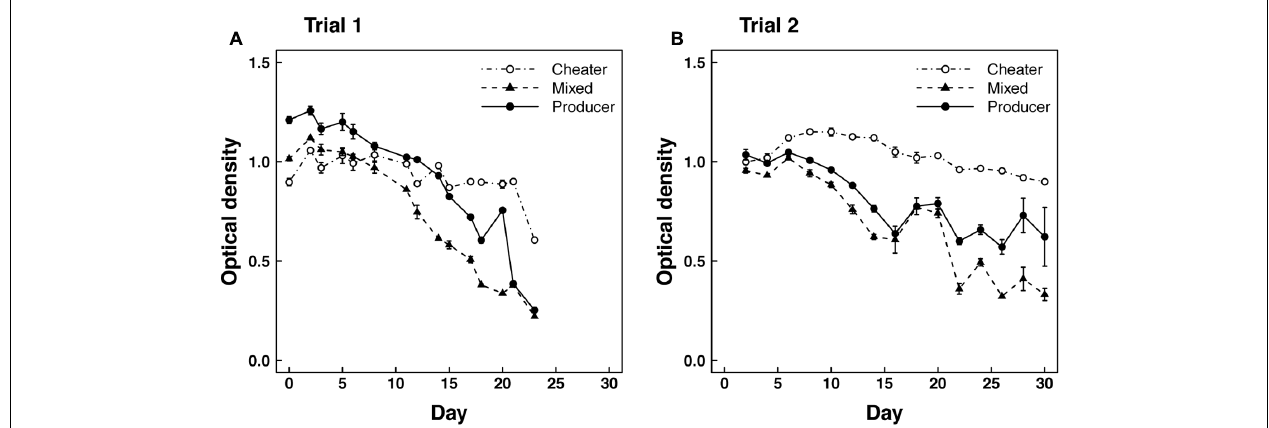
FIGURE 1 | Optical density over time in (A)Trial 1 and (B)Trial 2 for cheaters grown alone on hydrolyzed casein and producers grown alone or mixed (50–50%) with cheaters on casein medium.